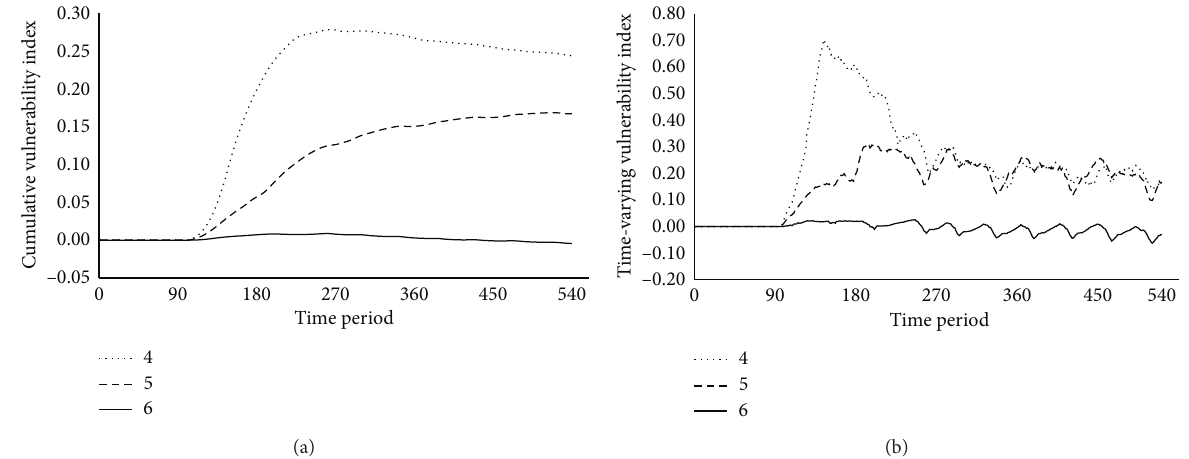
Figure 7: Vulnerability variation diagram under link partial failure. (a) Cumulative vulnerability when setting the road link 24 ⟶ 25 failed. (b) Time-varying vulnerability. (a) Cumulative vulnerability. (b) Time-varying vulnerability.